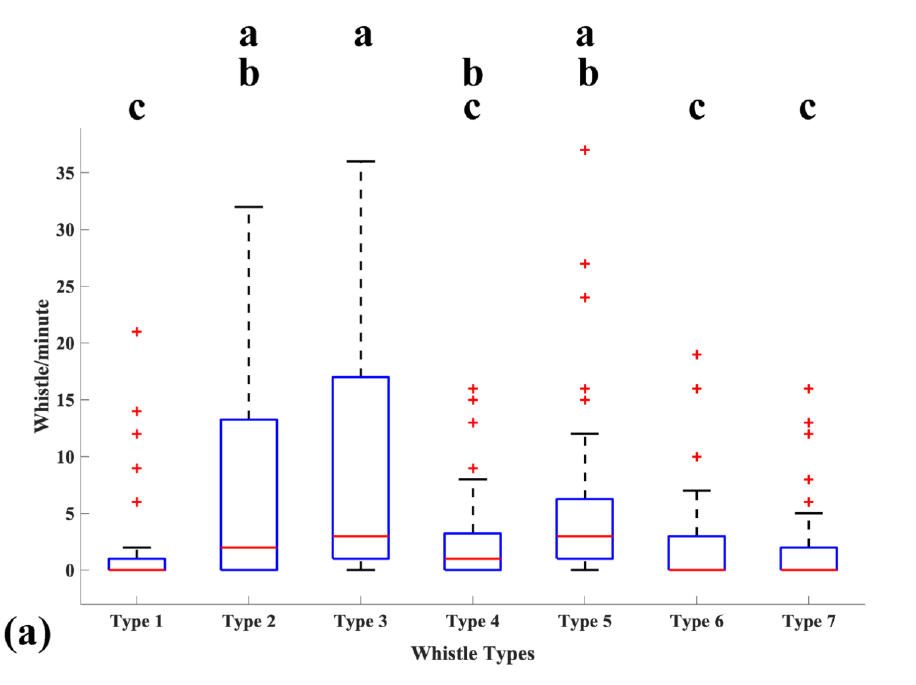
Figure 3. ( a ) Frequency of whistle types per minute (number of replicates in group, whistle Type 1– 7; n = 16, 36, 45, 27, 49, 22, and 18, respectively). Effect of vessel transit (before [ n = 9 min], during [ n = 7 min], and after [ n = 9 min]) on ( b ) Sound pressure level (SPL, dB re 1 μ Pa), ( c ) number of whistles, ( d ) number of clicks, and ( e ) whistle duration (s) within a minute. The central red mark on each box indicates the median, and the top and bottom edges of the box represent the 25th and 75th